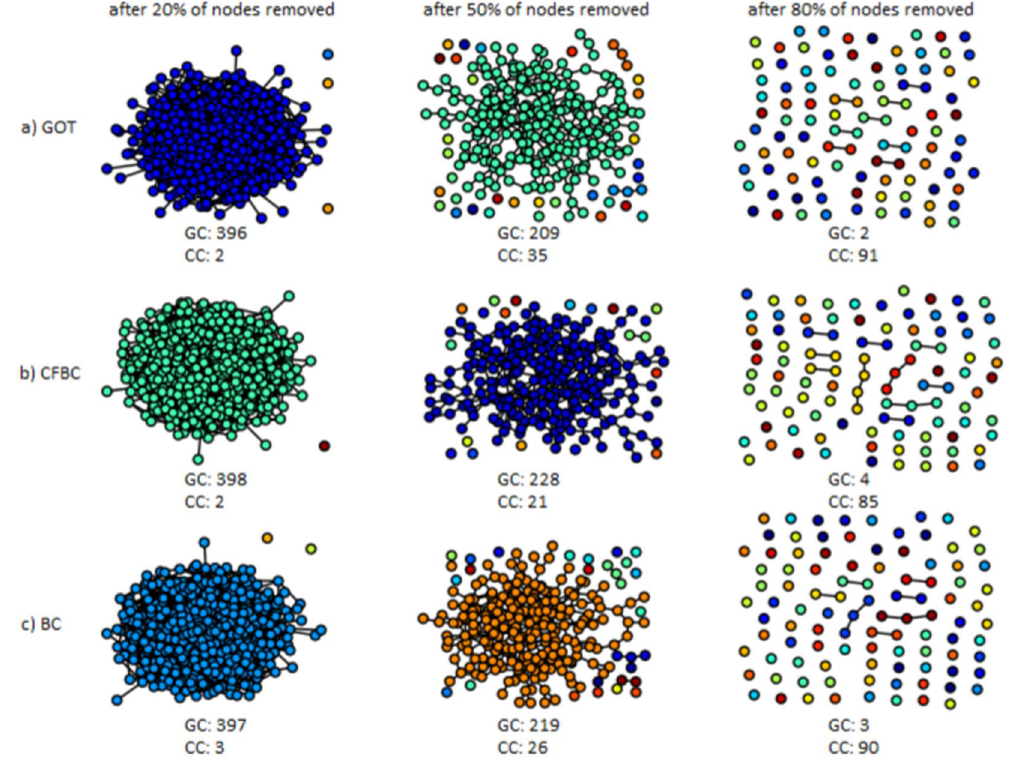
Figure 7. NRP procedure - nodes. Snapshots during the NRP procedure for nodes in a random generated network with 500 nodes. At the bottom of each subplot, the number of connected components (CC) and the size of the giant component (GC) are